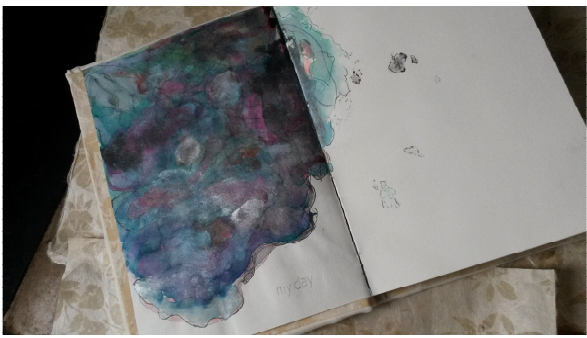
Figure 11. My day fragment, 2015. © Silvia Loeffler, Glas Journal,